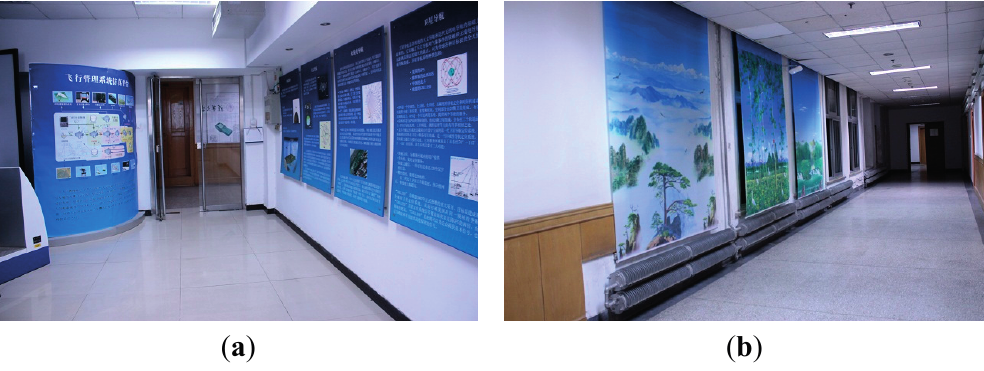
Figure 6. Experiment system: a prototype quadrotor MAV equipped with a RGB-D camera and a low-cost MEMS IMU module. ( a ) Prototype quadrotor MAV system; ( b ) MEMS IMU: ADIS16405; (c) RGB-D Camera: PrimeSense Carmine 1.08.